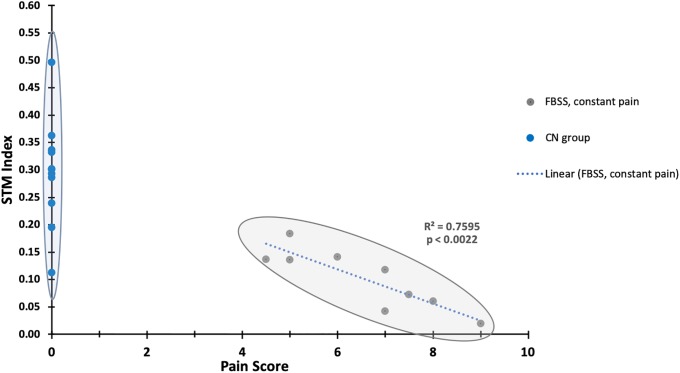
Clinical significance of STMFCS.A negative linear relationship was found between STMFCS and the corresponding pain scores in FBSS group (gray). STMFCS index is the mean FC between STM and all other 6 networks. Mean STMFCS index for control (CN, blue) group is 0.27, STD 0.13.